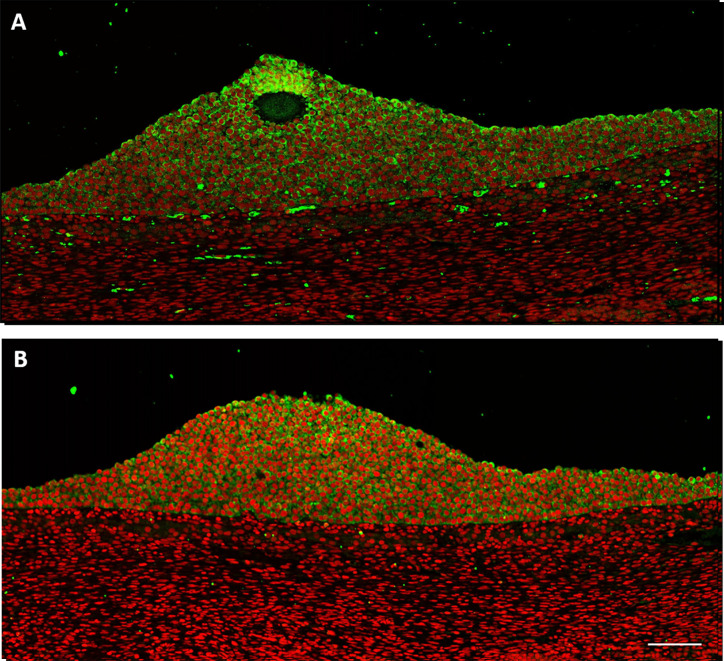
Human small antral follicle (5 mm). (A) AMHC (green) is expressed in cumulus cells with increasing intensity toward the oocyte. Nucleus (red). (B) AMHN (green) is expressed in cumulus cells close to the oocyte. Scale bar: 100 µm.